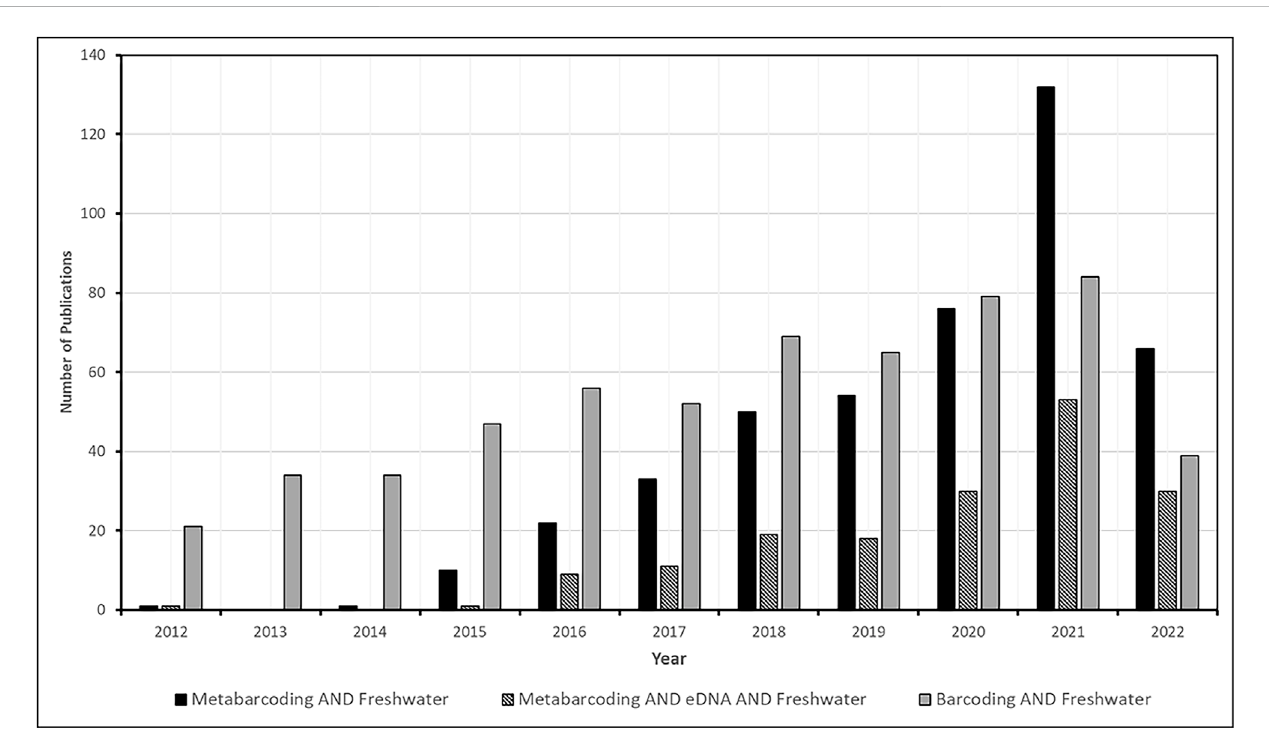
FIGURE 1 Comparison of different types of studies since the conception of metabarcoding and eDNA for freshwater